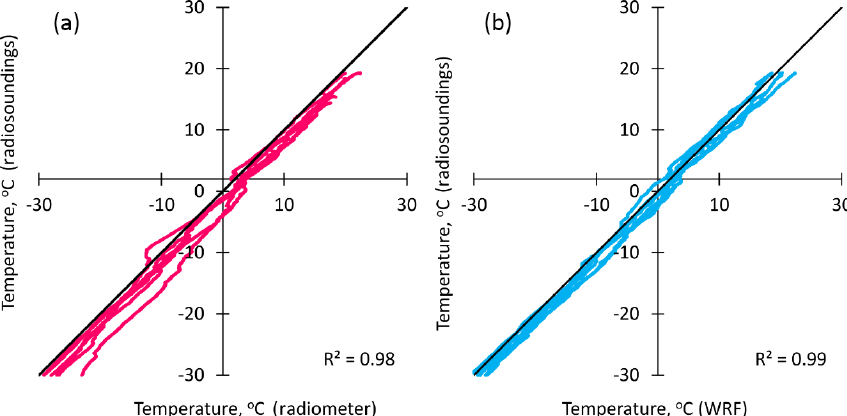
Figure 4. Temperature profiles intercomparison for all heights. All six high-resolution radiosounding cases from the HygrA-CD campaign are used (15, 17, 18, 20, 21 May and 1 June): radiosoundings versus radiometer ( a , red) and radiosoundings versus WRF model simulations ( b ,